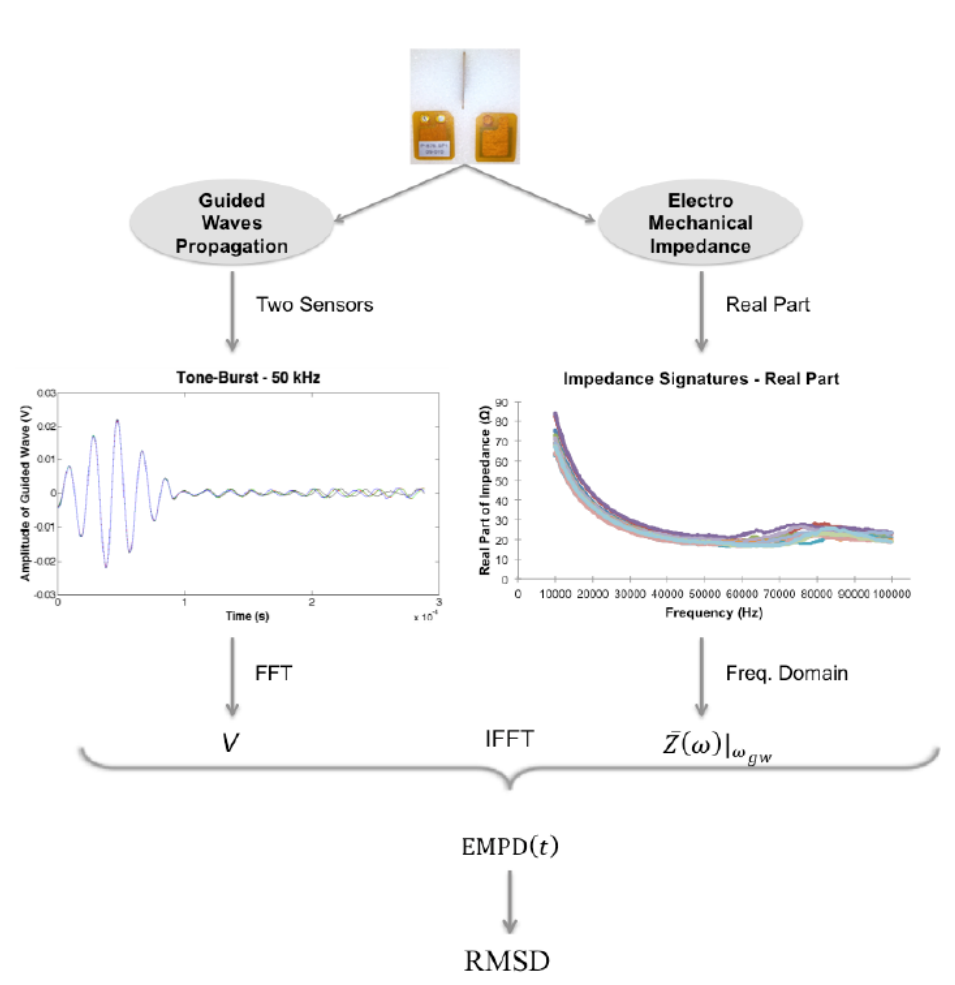
Figure 1. Overall procedure to extract the Damage Indicator based on Electro-Mechanical Power